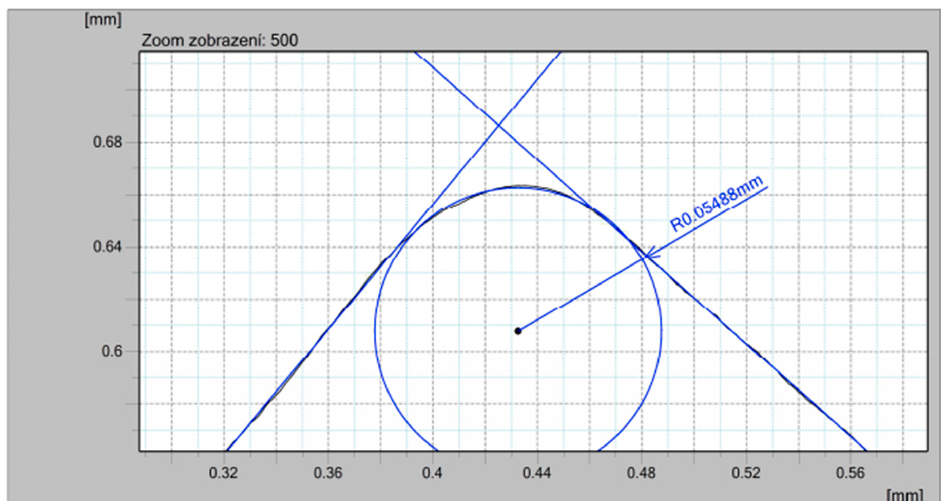
Figure 3. Cutting edge radius obtained by contour graph.